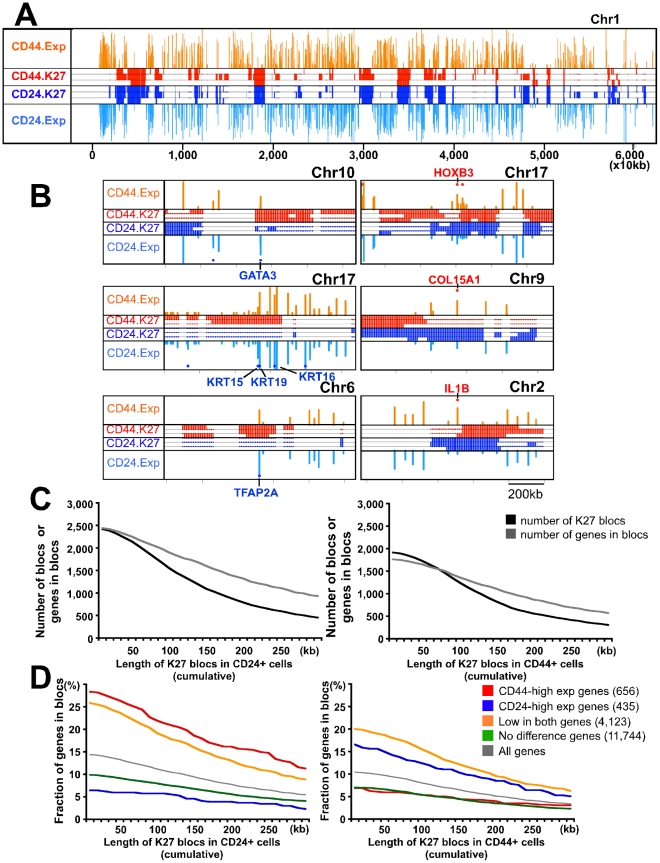
Genome-wide H3K27me3 patterns of human mammary epithelial progenitor and differentiated luminal cells.(A) Patterns of K27 enrichment and gene expression are mutually exclusive. Representative example of K27 distribution and gene expression in chr1. Data was analyzed using SICER algorithm [28] using 10 kb as window size. Significantly enriched regions and gene expression levels are plotted as colored lines across chromosome position. Red and blue lines represent K27 enrichment in CD44+ and CD24+ cell libraries from three different individuals, respectively. Gene expression levels are plotted across chromosome position. The height of line indicates the level of expression of corresponding gene. Orange and light blue: median expression in CD44+ and CD24+ samples, respectively. (B) Representative examples showing that distinct K27 distributions correlate with gene expression using the same plot as in panel A but at different scale. Red and blue dots indicate genes highly expressed (>2 fold difference) in CD44+ and CD24+ cells, respectively. Clear differences in K27 distribution between the two cell types are observed consistently in the regions where the selected genes are located. (C) Correlations between the number of K27 blocs and the number of genes in these blocs in CD44+ (left) and CD24+ (right) cells depending on setting K27 blocs at different sizes. X-axes indicate the threshold of length for defining K27 blocs, whereas y-axes show the number of K27 blocs and the number of genes within these blocs. (D) Fraction of genes with the indicated expression pattern located within K27 blocs in CD44+ and CD24+ cells.